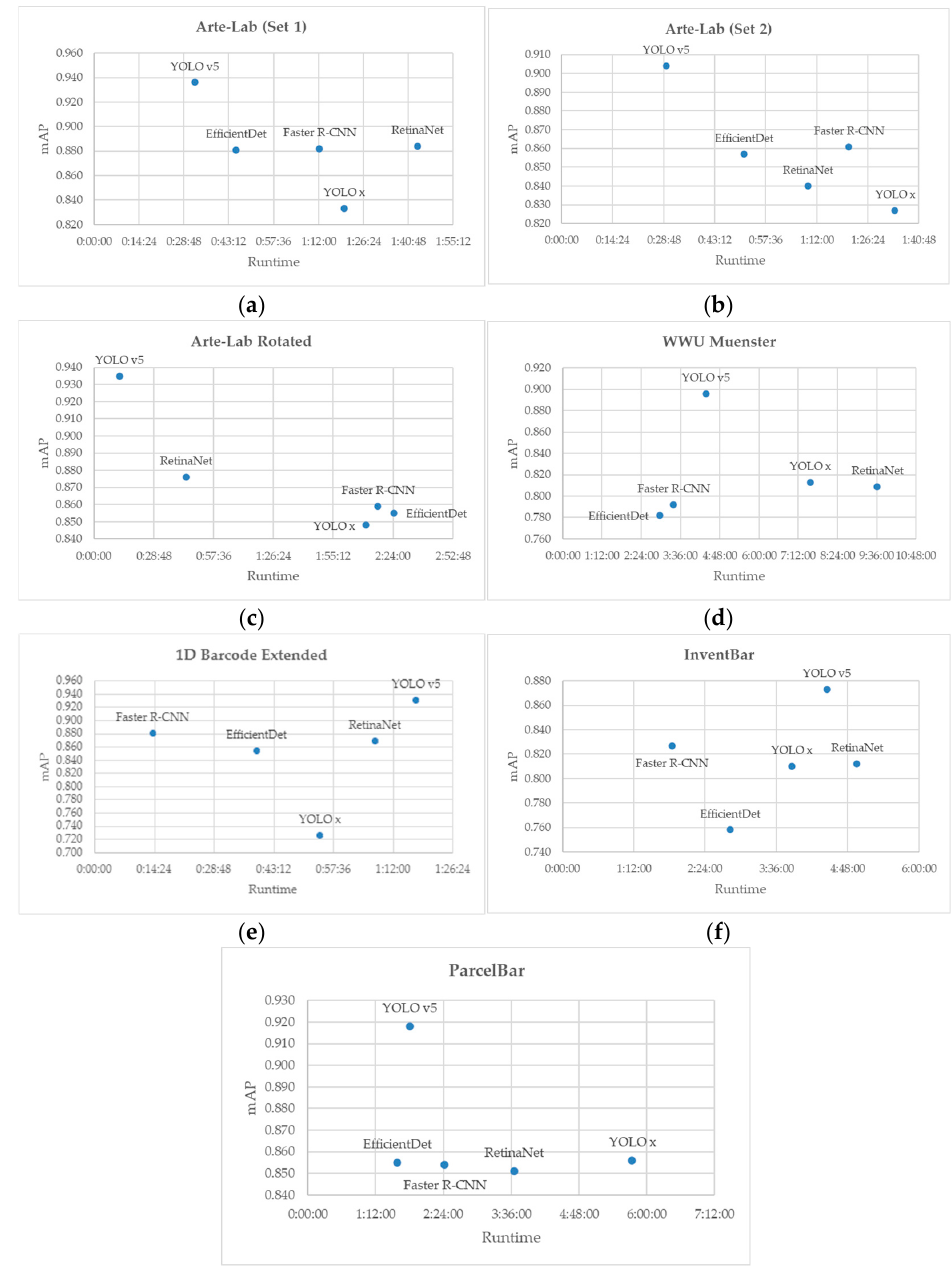
Figure 9. Runtime performances of the D-CNN methods applied over seven public barcode datasets: ( a ) Arte-Lab Medium Barcode (Set 1), ( b ) Arte-Lab Medium Barcode (Set 2), ( c ) Arte-Lab Rotated Barcode, ( d ) WWU Muenster, ( e ) 1D Barcode Extended, ( f ) InventBar, and ( g ) ParcelBar.